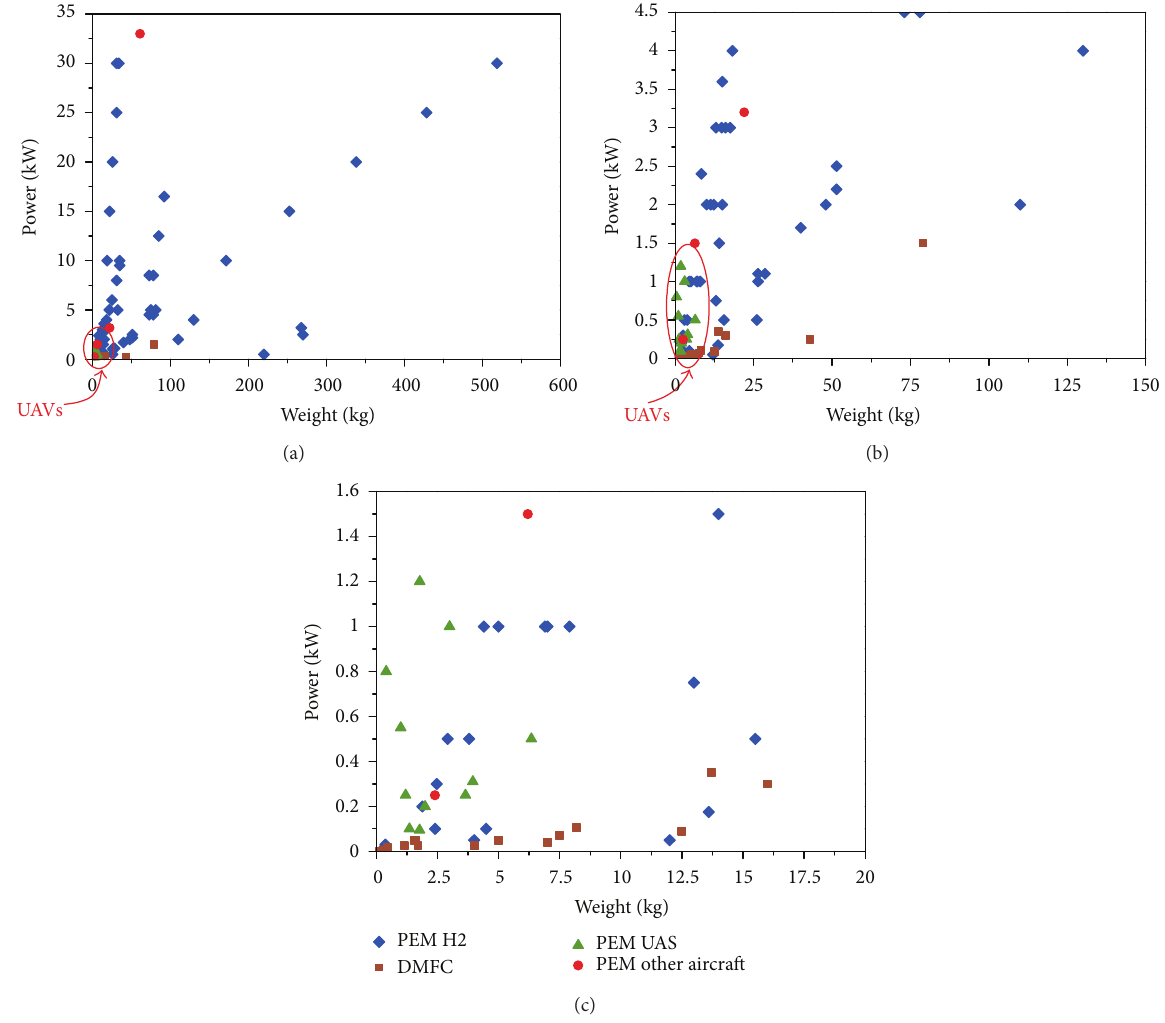
Figure 8: Power versus weight of PEM and DMFC commercial fuel